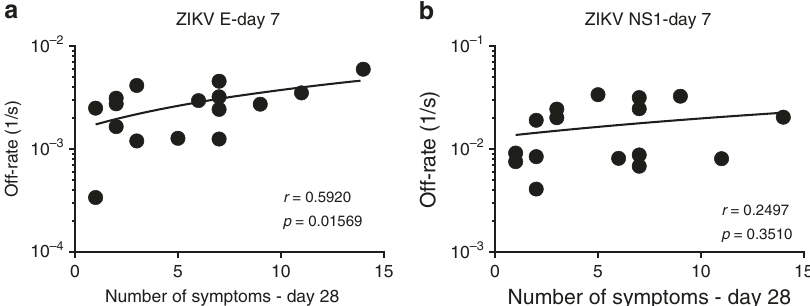
Fig. 7 Relationship between serum antibody af fi nity with Zika virus (ZIKV) clinical symptoms. Antibody off-rate constants of the polyclonal serum sample interaction with recombinant ZIKV-E ( a ) and NS1 ( b ) proteins on day 7 visit as measured by SPR was correlated with total number of symptoms on day 28 visit for the corresponding patient. Inverse Spearman correlations were observed between anti-ZIKV-E antibody af fi nity on day 7 measured by SPR vs. number of symptoms on day 28 ( r = 0.592; p = 0.01569). Source data are provided as a Source Data fi